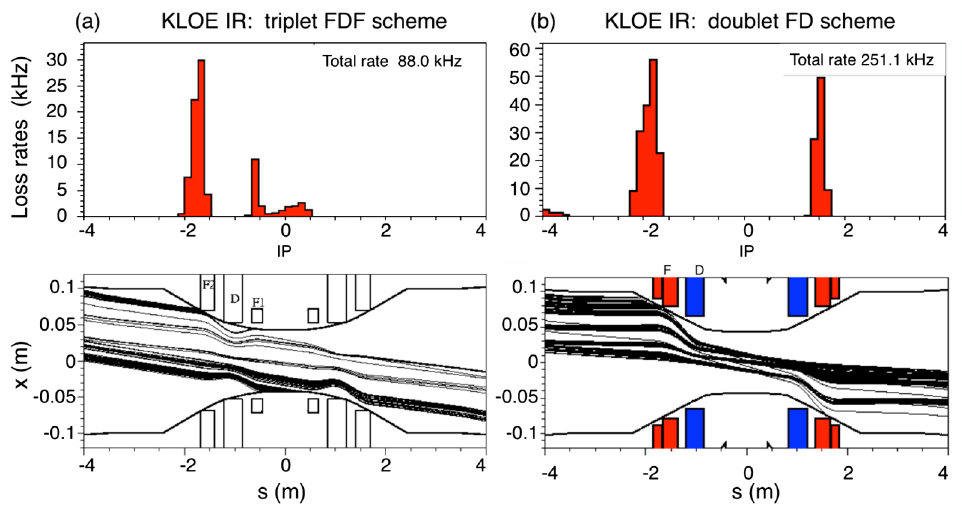
FIG. 11. Upper and lower plots show distribution and trajectories of Touschek particles lost at the KLOE IR for the two low- (cid:6) configurations: (a) focusing-defocusing-focusing quadrupoles; (b) focusing-defocusing quadrupoles, successfully used for KLOE masks design.